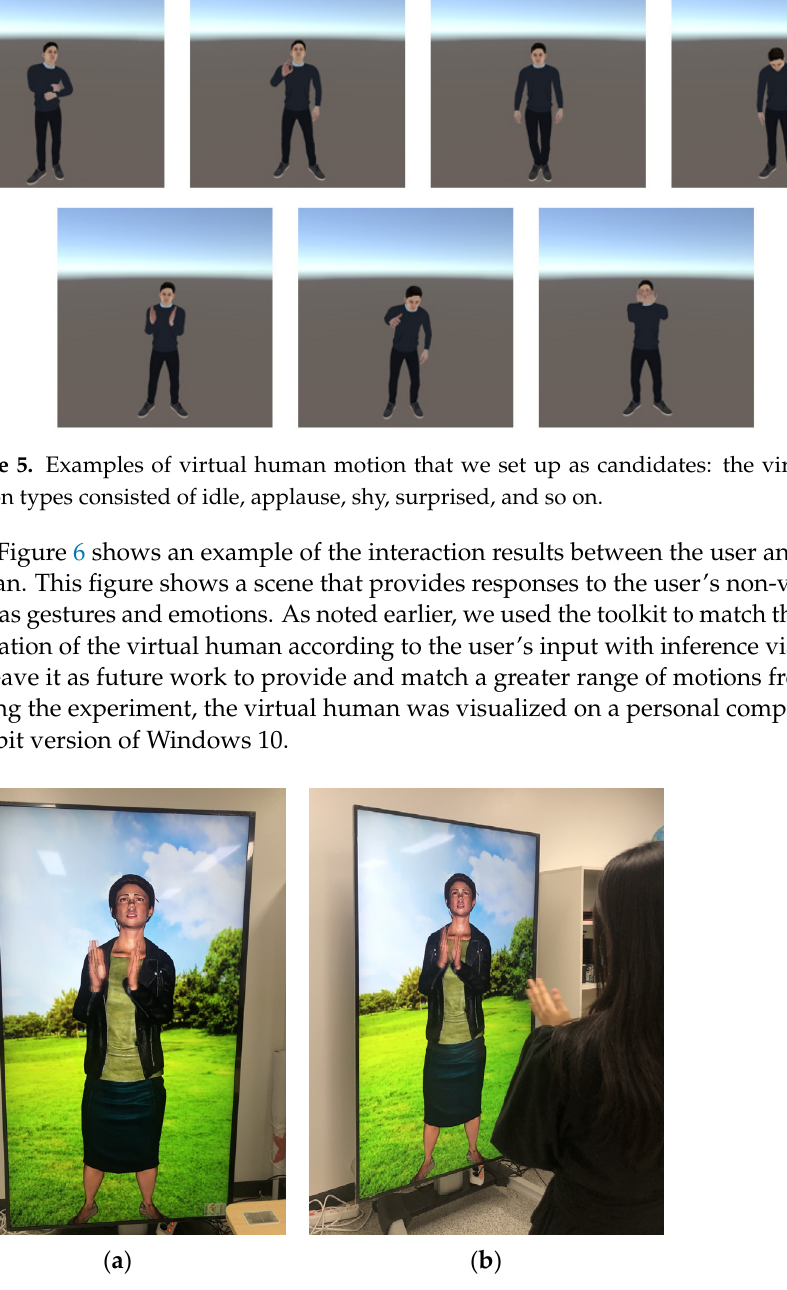
motion (e.g., applause animation) responding to the user. This motion was the result of optimal